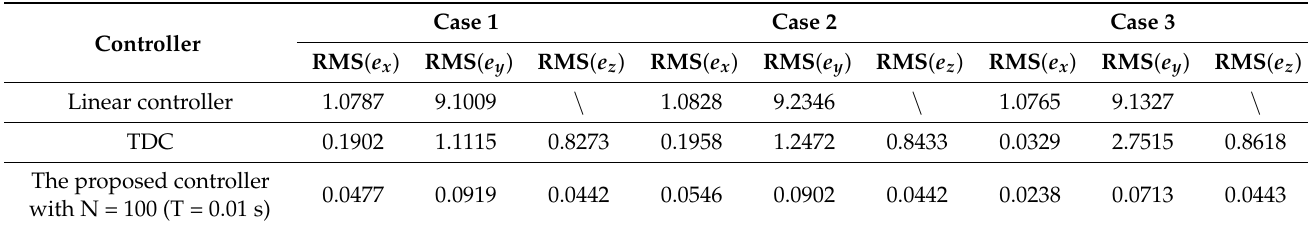
Figure 7. AUV 3D position tracking and tracking errors for various controllers under different noise conditions ( T = 0.01 s): ( a ) noise case 1, ( b ) noise case 2, and ( c ) noise case 3. Table 5. RMS errors (m) for various